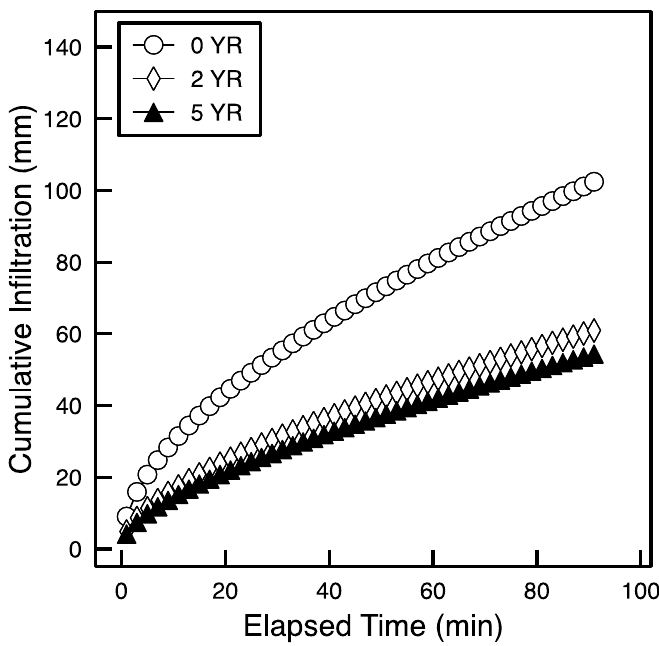
Figure 3. Cumulative infiltration curves obtained by Philip’s model for the three experimental plots subjected to different irrigation treatments (0YR, 2YR, and 5YR).